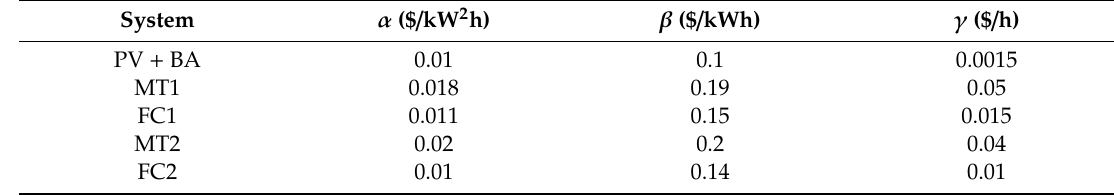
Figure 5. Simulation system for direct current (DC) microgrid. Table 1. Cost function parameters of